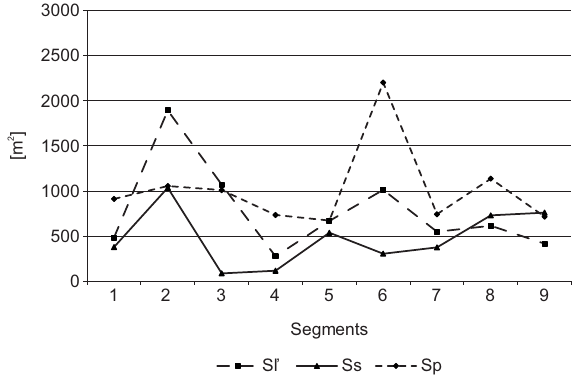
fig. 4. Bar areas on the left (Sľ), centre (Ss) and right side (Sp).